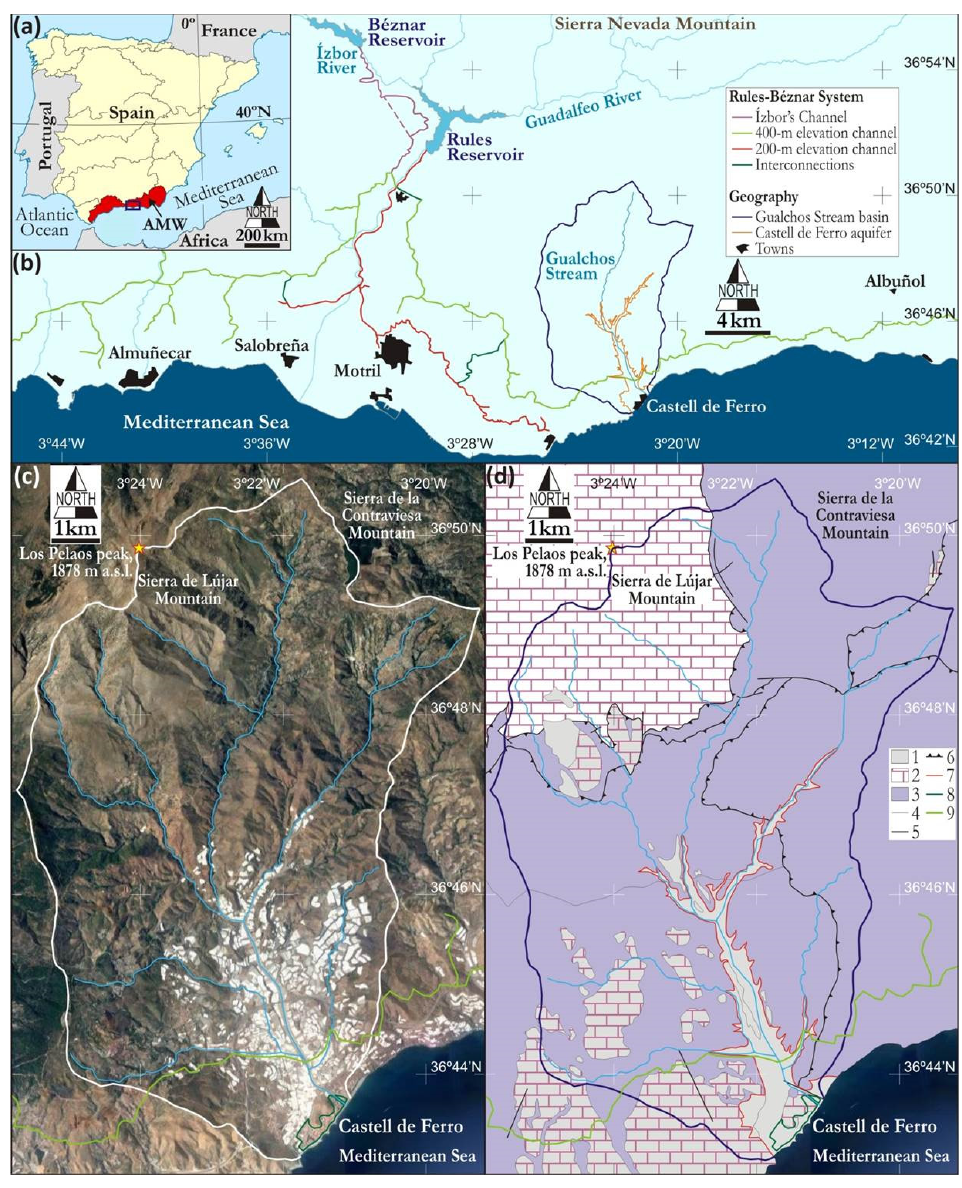
Figure 1. ( a ) Location of the Andalusian Mediterranean Watershed in Southern Spain. ( b ) Location of the Rules–Béznar System (RBS, box in ( a ) of hydraulic infrastructures (reservoirs and channels) in the coastal fringe of the Granada Province. Coastal aquifers are brown areas. ( c ) Satellite image of the GSB in 2021 (source: Google Earth), showing the greenhouses occupation (white spots). ( d ) Simplified hydrogeological map of the GSB from [45,53], showing the main aquifers (1—Quaternary alluvial; 2—Triassic carbonates) and bedrock (3—metapelitic rocks), as well as other geographic features (4—geological contact; 5—Castell de Ferro alluvial aquifer; 6—urban area; 7—the 400 m elevation channel from RBS).